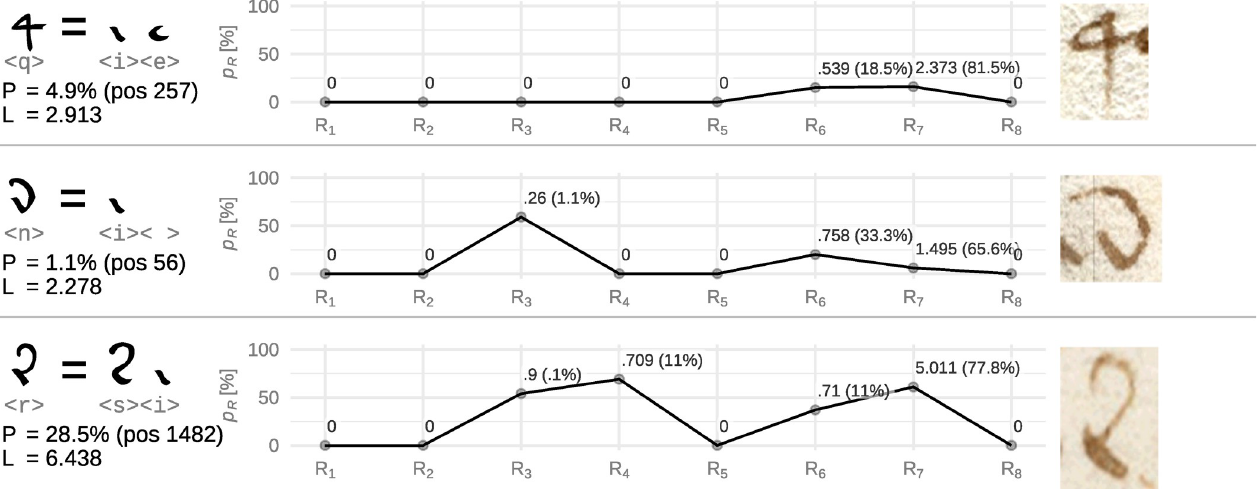
Fig 7. Loss scores of ligature candidates < q > , < n > , < r > . See Fig 6 for details. Symbol illustrations were taken from: f13v, f30v, f27v.